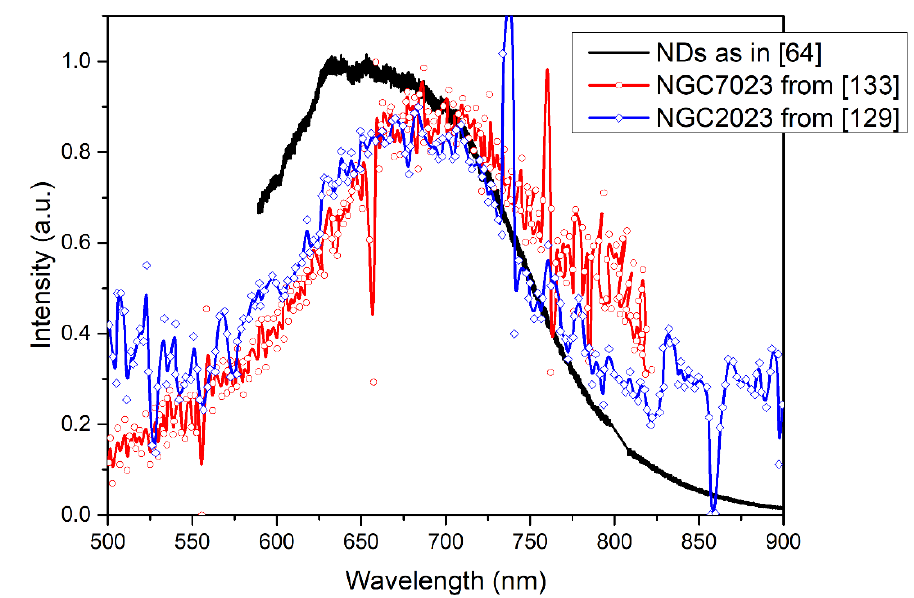
Figure 21. The black line is the PL spectrum under a 532 nm pump of PLA NDs containing NV centers, while the blue and red curves are typical ERE emissions, pertinent to NGC2023 and NGC7023 nebulae Data reproduced from [64] (black curve), [133] (red curve) and [129] (blue curve).